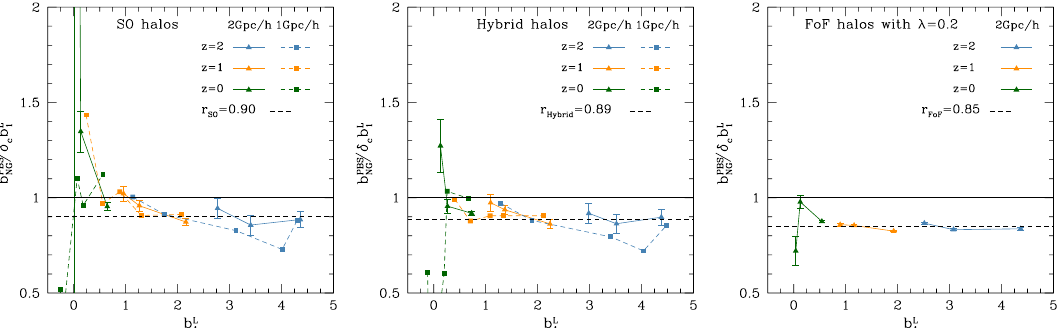
Figure 4. Comparison between PBS and universal predictions for three mass bins and at redshifts z = 0,1 and 2. The different panels show results for different halo finders: SO, Hybrid (combination of FoF and SO, Rockstar code [332]) and a pure FoF with linking length λ = 0.2. Black dashed lines (cid:38) 1 for each finder. Credits to indicate the fitted constant value of b PBS / δ sc b G at b G 1 1 NG